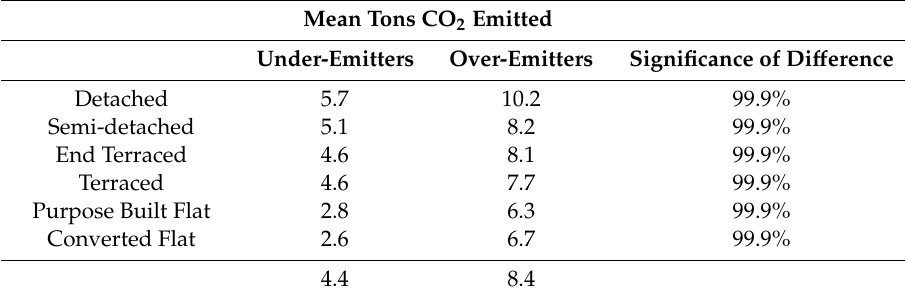
Table 2. Analysis of housing type and emissions (including transport) for those in